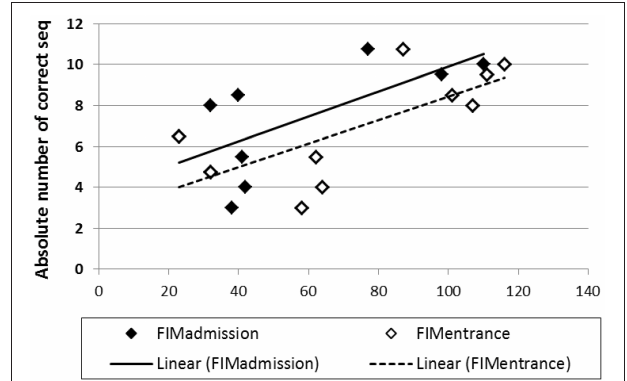
FIGURE 7 | Correlations between performance speed in the initial pre-test (Test 1) and total FIM scores at admission (filled diamonds) and study entrance time points (open diamonds), x